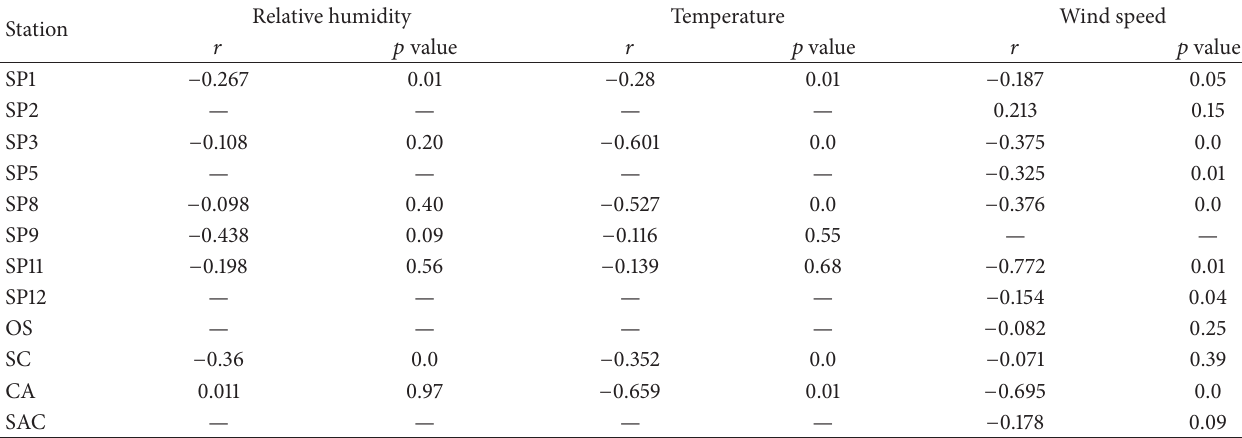
Table 3: Correlation coefficient ( 𝑟 ) between monthly averages of each meteorological variable and CO concentration and results for the hypothesis test.